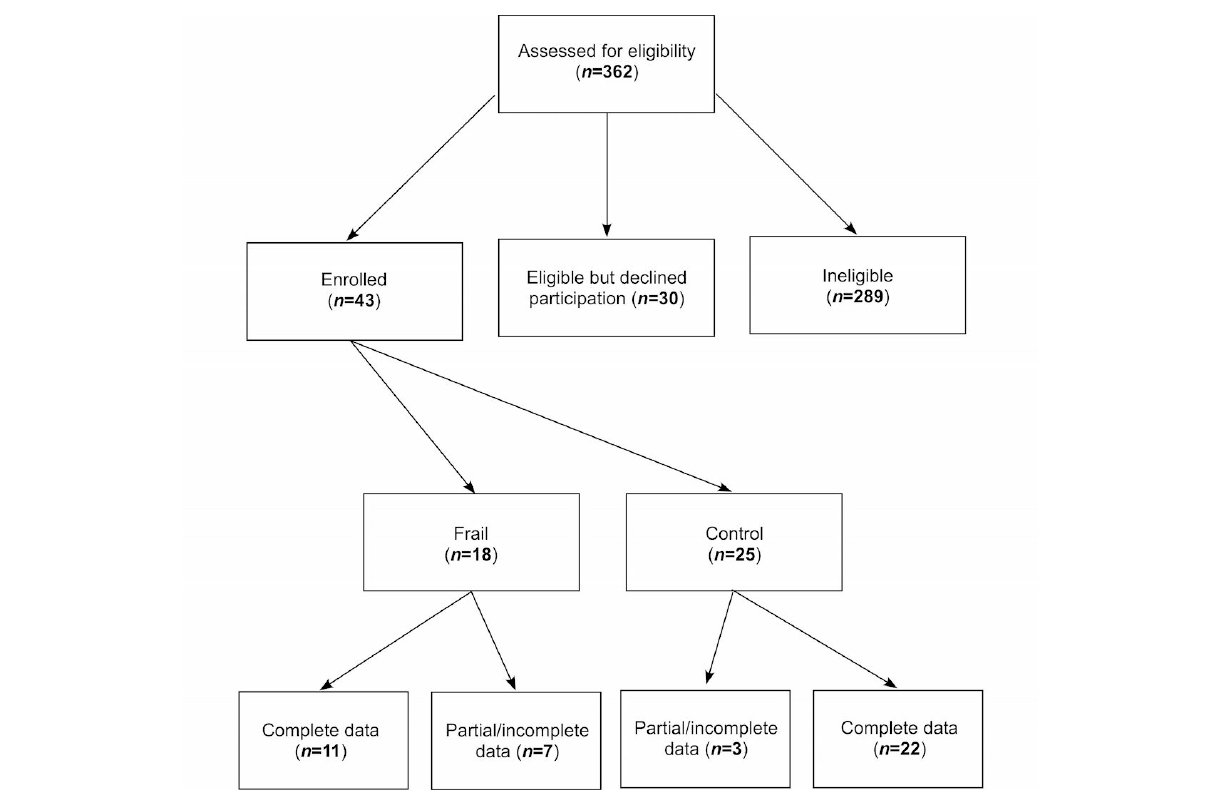
Figure 1. Enrollment flow